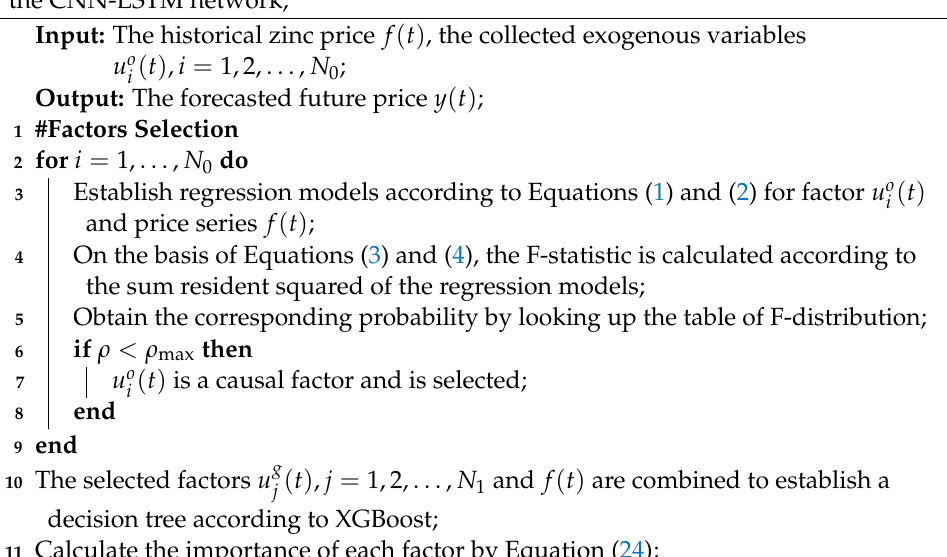
Algorithm 1: Price forecasting based on multi-factor selection and fusion with the CNN-LSTM